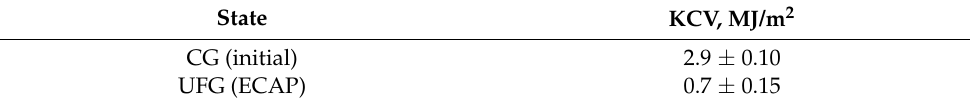
Table 5. Impact toughness (KCV) of the CG and UFG steel at a temperature of 20 ◦ C.